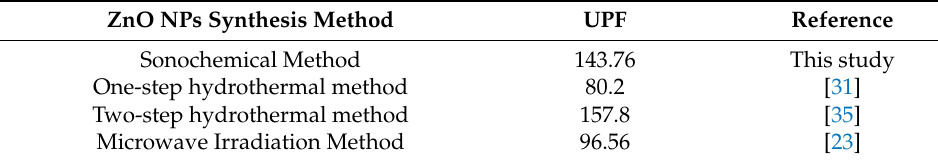
Figure 11. UPF values vs. Zn contents. Table 8. Comparison of UPF.